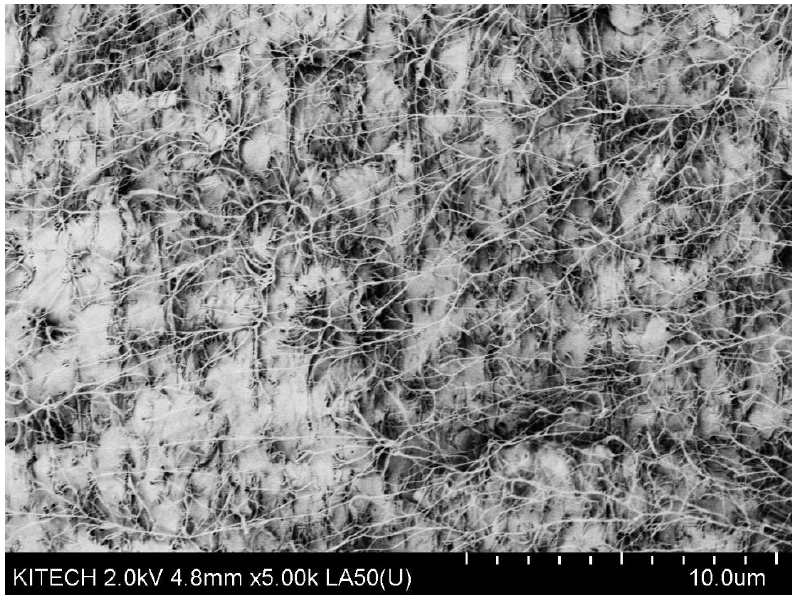
Figure A5. SEM image of the 4.29 wt.% SWNT/PP composite.